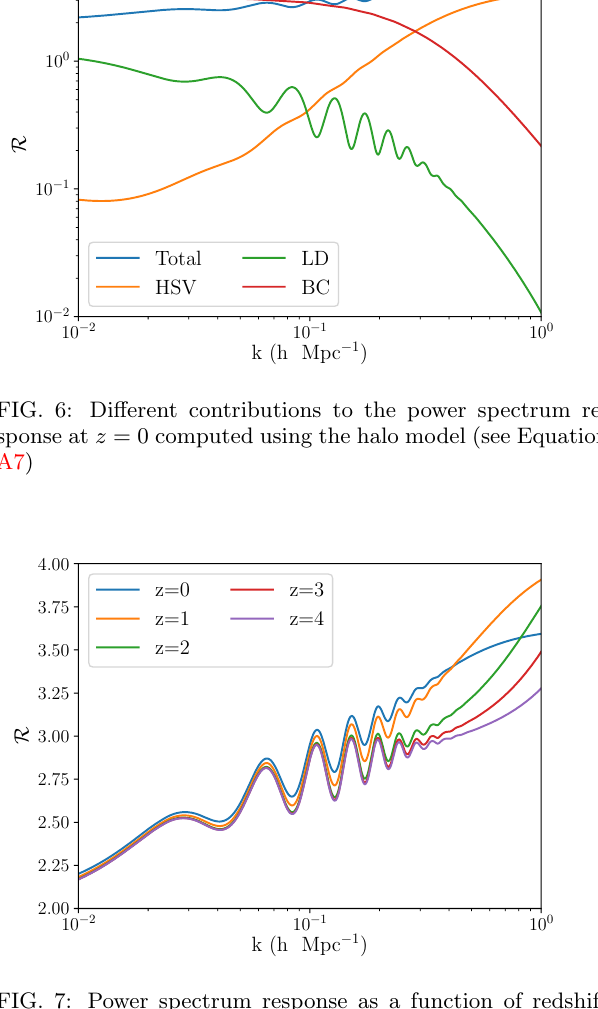
FIG. 7: Power spectrum response as a function of redshift computing using the halo model.